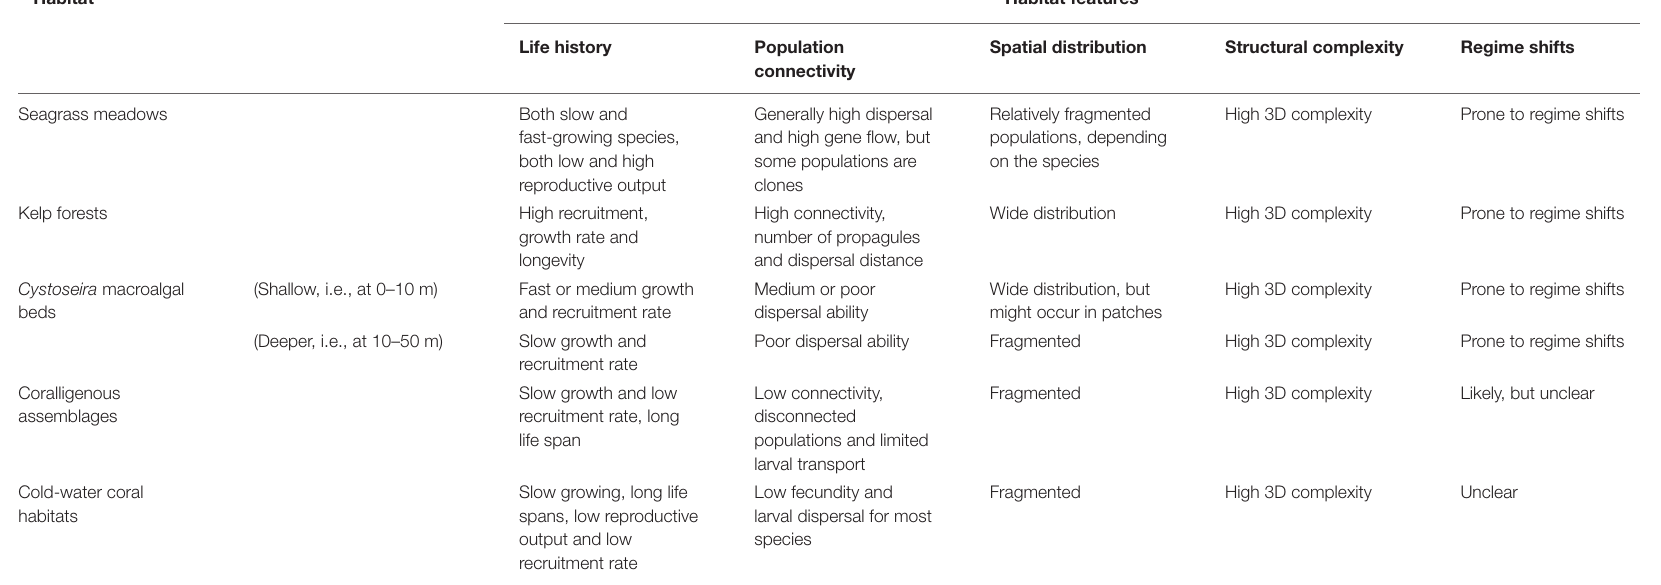
Shallow Cystoseira macroalgal beds have a different community and different life history traits than deeper ones and are thus treated